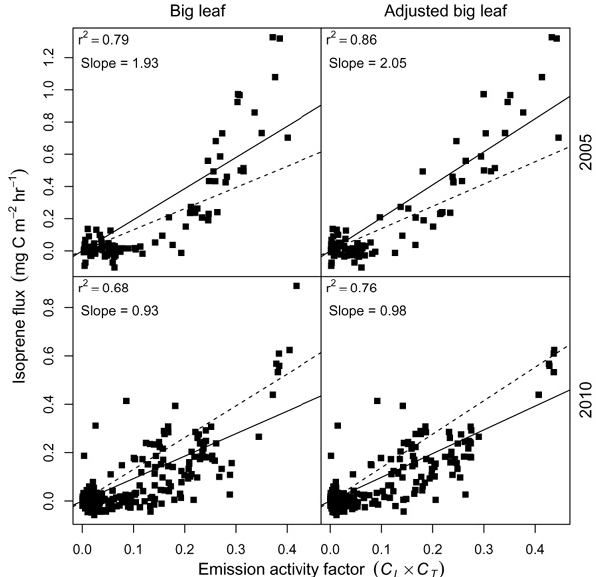
Fig. 5. Left-hand panels: a model of whole-ecosystem isoprene fluxes using the G93 algorithms and treating the tundra as a single “big leaf” for each year (Eq. 4). Model predictions of the impact of temperature and light ( C L × C T ) are on the x-axis, the measure- ments of whole-system isoprene emissions (Emission canopy ) are on the y-axis and the canopy emission factor (EF canopy ) is the slope of the fitted line. Right-hand panels: the same model (Eq. 4), except that the α and C L 1 parameters in the G93 algorithm for light (Eq. 2) have been optimized. The solid line is the linear fit with a zero in- tercept between the model and the observations for each individual year. The dashed line is the same fit for both years (EC05 and EC10) combined. The statistics for the combined fit with the original big- leaf model (two left-hand panels) are r 2 = 0 . 66 and slope = 1.31 and with the adjusted big-leaf model (two right-hand panels) are r 2 = 0 . 73 and slope